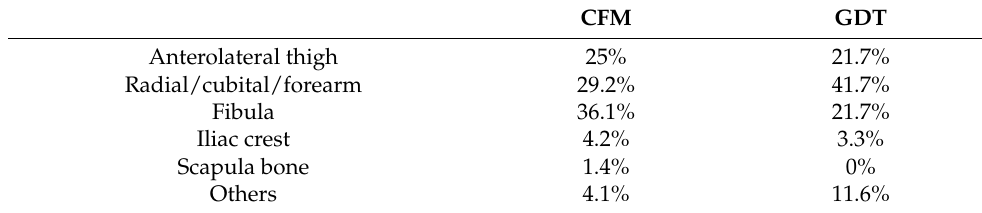
Table 4. Free flap types